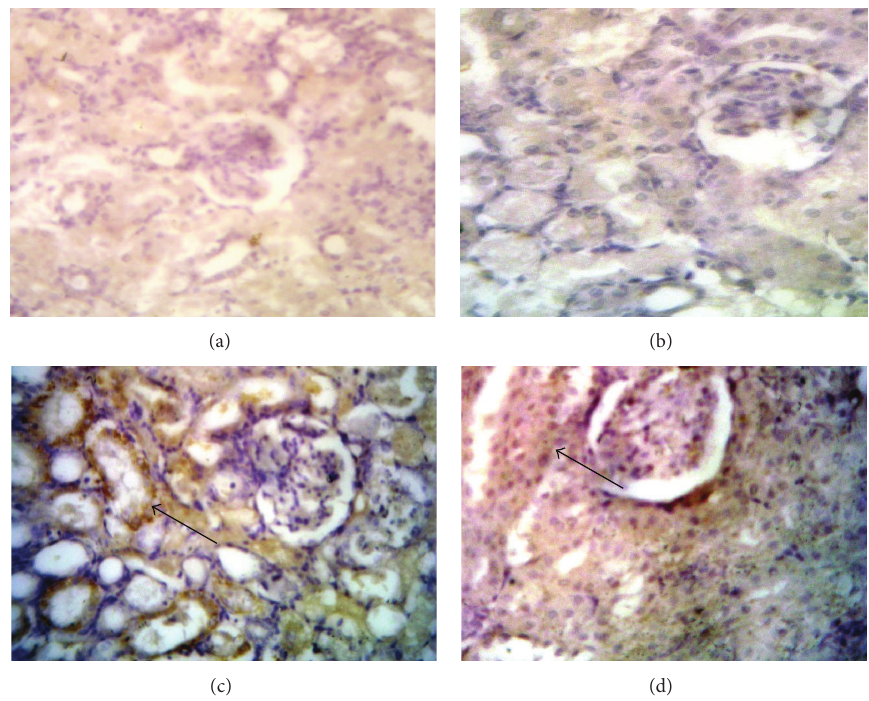
Figure 3: Effect of sildenafil on inducible nitric oxide synthase (iNOS) immunohistochemical staining of gentamicin-treated rat kidney ( × 400). Localization of iNOS immunoreactivity in the kidney cortex of (a) and (b) control and sildenafil treated groups, respectively, showing negative immunoreactivity, (c) gentamicin-treated group showing high cytoplasmic expression within the renal tubules (arrow), and (d) gentamicin and sildenafil treated group showing faint cytoplasmic expression within few renal tubules (arrow). Table 1: Effect of sildenafil on serum creatinine and urea as well as urinary albumin levels of gentamicin-induced nephrotoxicity in rats. Creatinine Urea Albumin Group mg/dL mg/dL mg/dL Control 0.53 ± 0.01 26.2 ± 0.24 0.36 ± 0.01 Sildenafil 0.55 ± 0.01 25.8 ± 0.17 0.34 ± 0.01 Gentamicin 3.1 ± 0.1 ∗∘ 139 ± 1.48 ∗∘ 4.05 ± 0.10 ∗∘ Gentamicin + sildenafil 0.94 ± 0.01